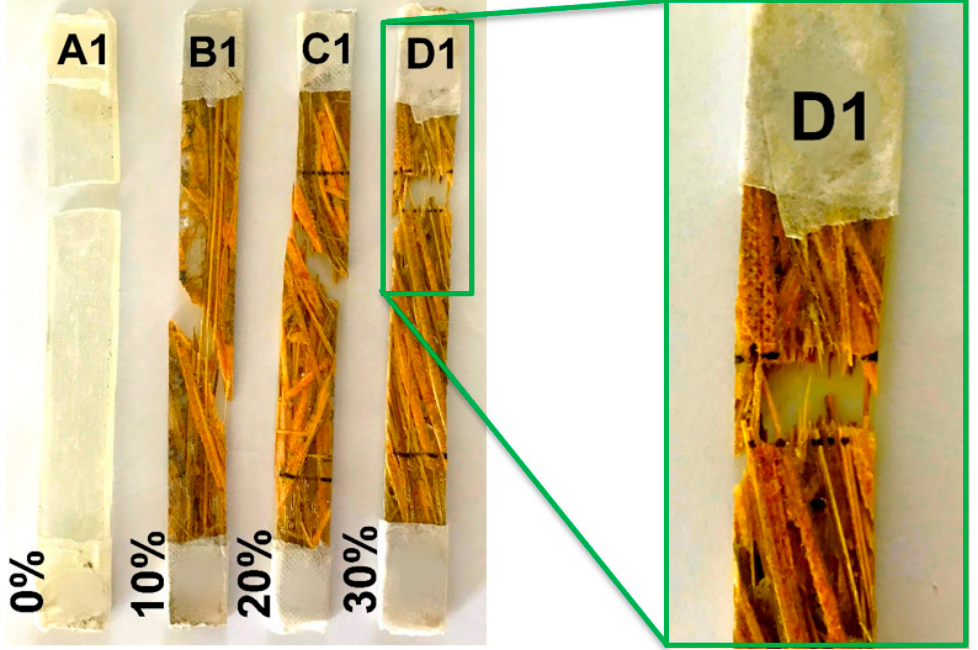
Figure 6. Typical broken specimens of the caranan fiber epoxy composite after the tensile test.